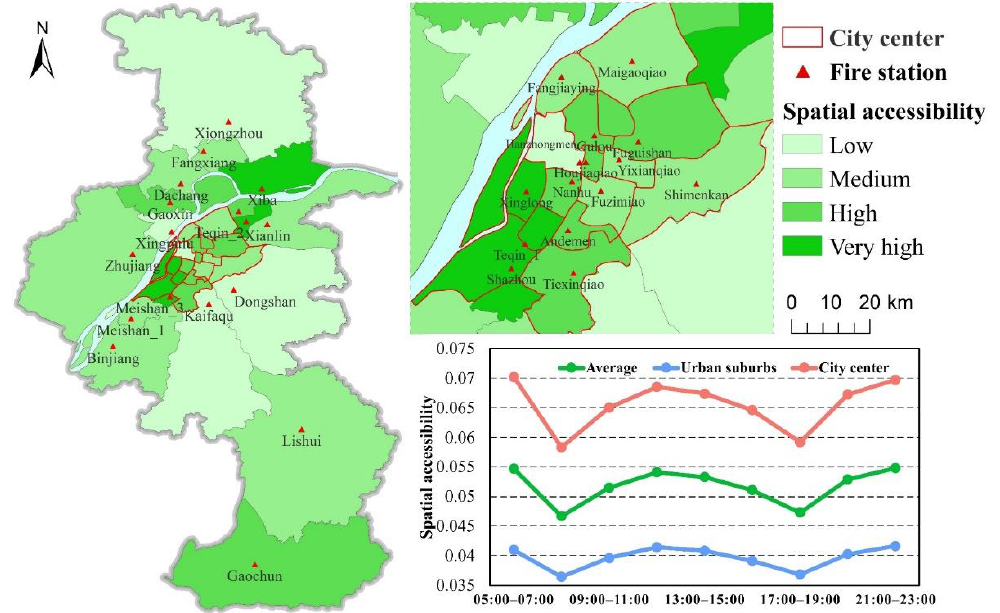
Figure 5. Spatiotemporal pattern of accessibility of fire stations in Nanjing, China.